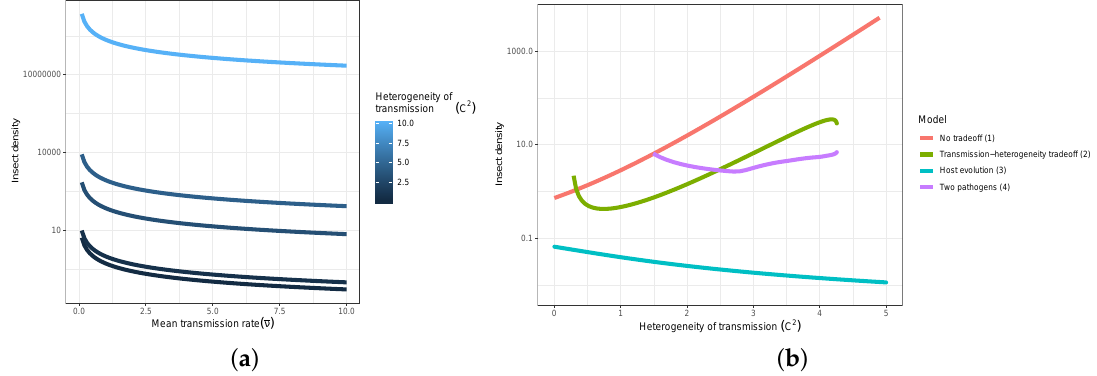
Figure 4. ( a ) Mean insect density ( log 10 ) as a function of the mean transmission rate, under different values for heterogeneity in transmission C 2 (Model 1). ( b ) Effects of heterogeneity of transmission and life history tradeoffs on the long-term insect population density for four different models. Models are numbered according to Table 1; note that Model 0 (linear transmission) is not included in ( b ) as it does not include heterogeneity of transmission. The four models shown here are: “No tradeoff (Model 1)” with mean transmission held constant at ¯ ν = 0.7 [72]; “Transmission-heterogeneity tradeoff (Model 2)”, with mean transmission ¯ ν as a non-linear increasing function of heterogeneity C 2 [79]; “Host evolution (Model 3)” in which mean transmission evolves in response to a tradeoff between host susceptibility and fecundity [15]; and “Two pathogens (Model 4)”, with one pathogen strain subject to the same tradeoff as in Model 2, and the other strain with constant ¯ ν = 0.7 and C 2 = 0.576. The two pathogen strain model is only shown for the range of heterogeneity values over which two-strain coexistence occurs. Models 2 and 4 do not cover the full extent of C 2 values because they are specifically constrained by the shape of the tradeoff curve shown in Box